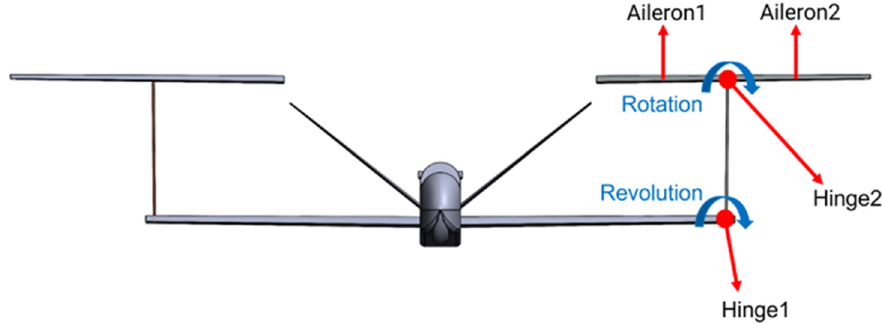
Figure 3. The aileron controls the aircraft to complete the process of morphing.